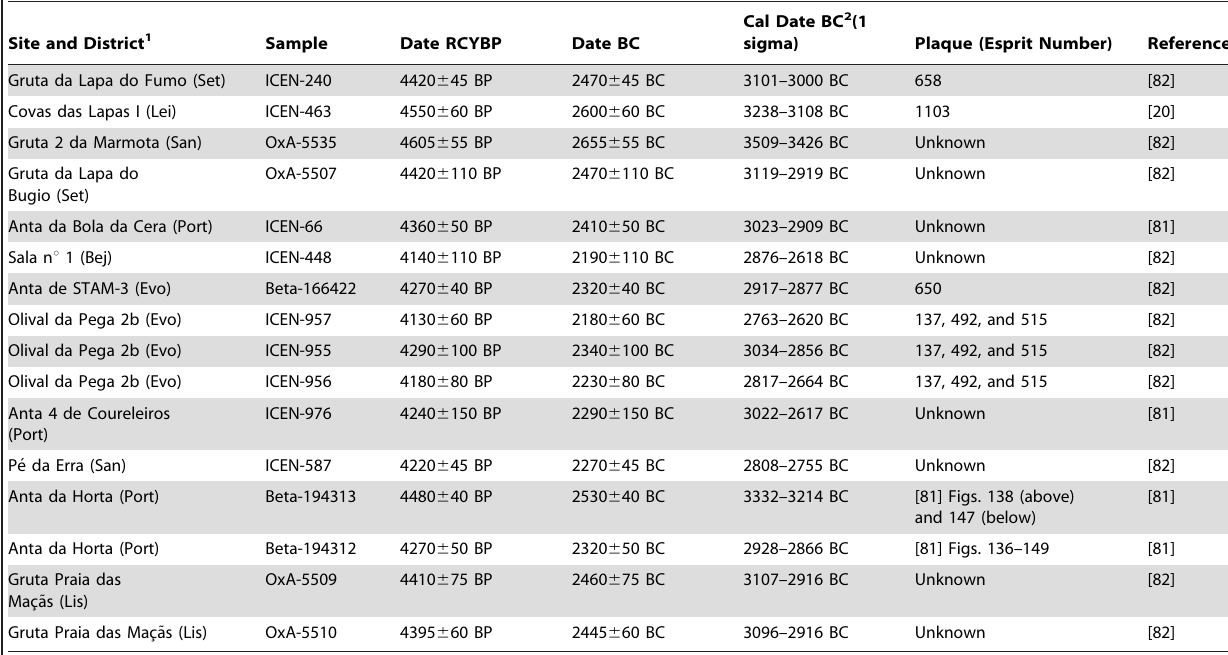
Table 1. Available radiocarbon dates directly associated with